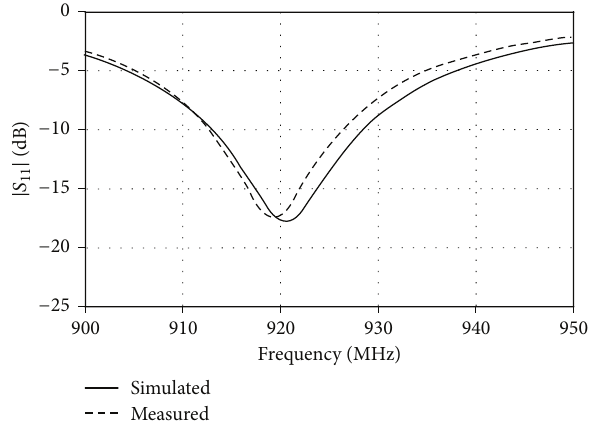
Figure 3: Simulated and measured |𝑆 11 |